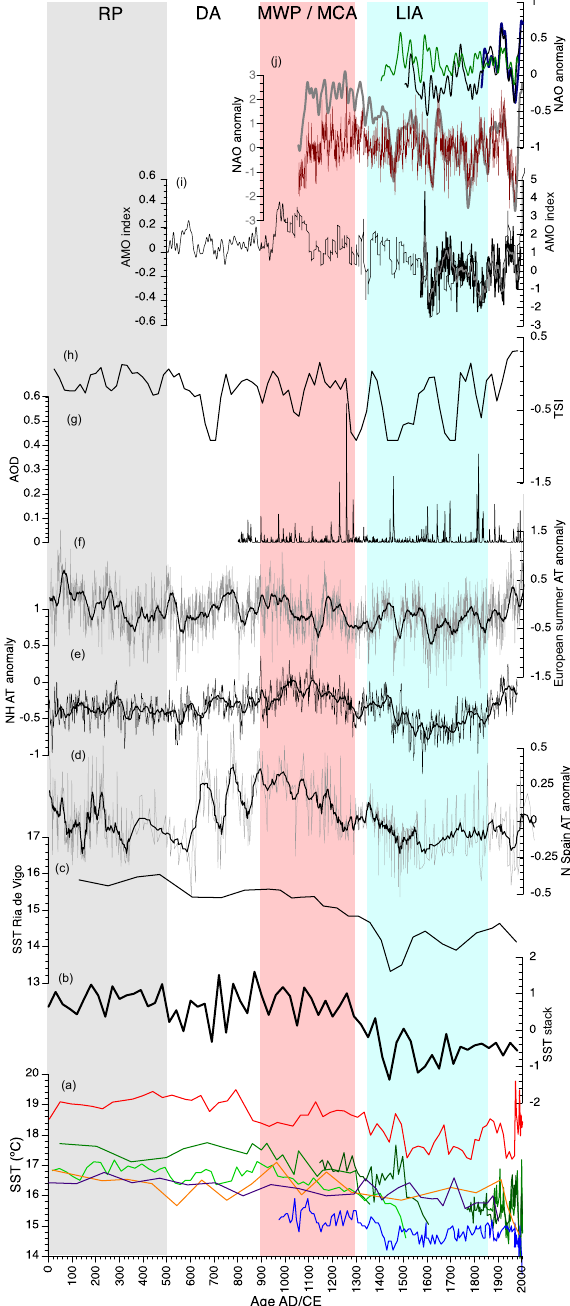
(cid:48) -SST over the last 2000 years at sites Galiza (orange), Minho (magenta), Porto (blue), Tagus (green) and Figure 2. Comparison of U k 37 (cid:48) Algarve (red) (a) ; SST stack constructed from all Iberian Margin records (b) ; U k -SST at Ria de Vigo (Diz et al., 2003) (c) ; Northern 37 Hemisphere annual mean atmospheric temperature anomaly (Moberg et al., 2005) (d) ; northern Spain atmospheric temperature anomaly (Martín-Chivelet et al., 2011) (e) ; European spring–fall atmospheric temperature anomaly (Luterbacher et al., 2016) (f) ; volcanic activity as aerosol optical depth (AOD) (Crowley and Unterman, 2013) (g) ; radionuclide-derived total solar irradiance (TSI) (Bard et al., 2007) (h) ; Northern Atlantic Ocean SST anomaly and AMO index (gray – Mann et al., 2010; black – Gray et al., 2004) (i) ; NAO index (Luterbacher et al., 2002; brown, Trouet et al., 2009) (j) . Light gray band marks the RP; the pink band marks the MCA; the blue band marks the LIA.